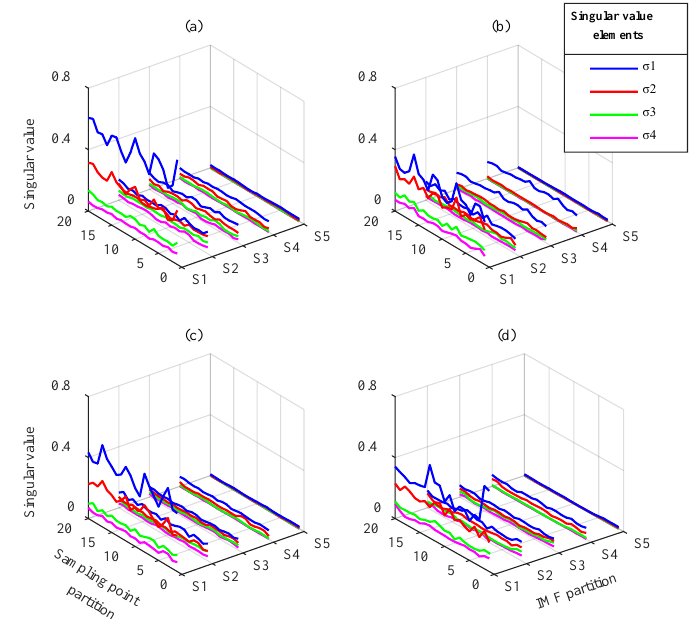
Figure 14. Degradation feature matrices from EEMD: ( a ) normal gear, ( b ) one-quarter breakage, ( c ) one-half breakage, and ( d ) three-quarters breakage.